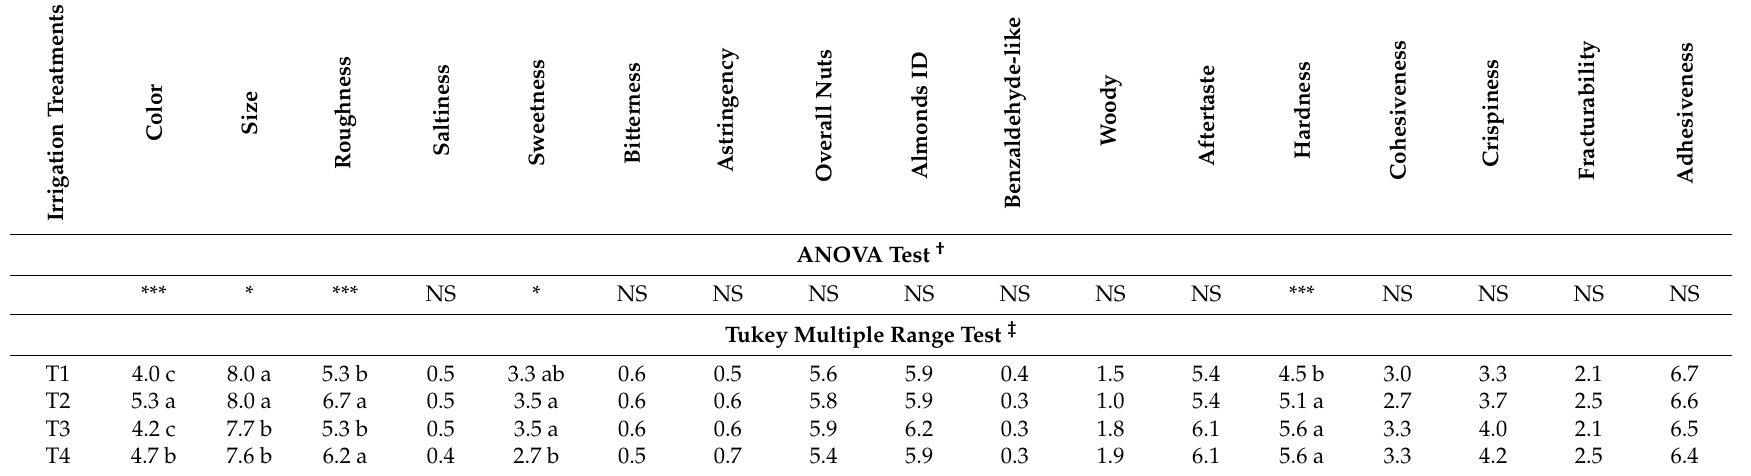
Table 2. Descriptive sensory analysis of raw almonds as affected by deficit irrigation. Scale used ranged from 0 = no intensity to 10 = extremely strong